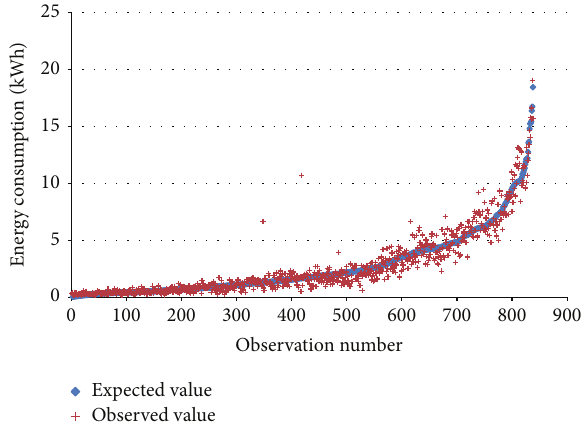
Figure 3: Observed and expected energy consumption of electric vehicle trips. Source: own